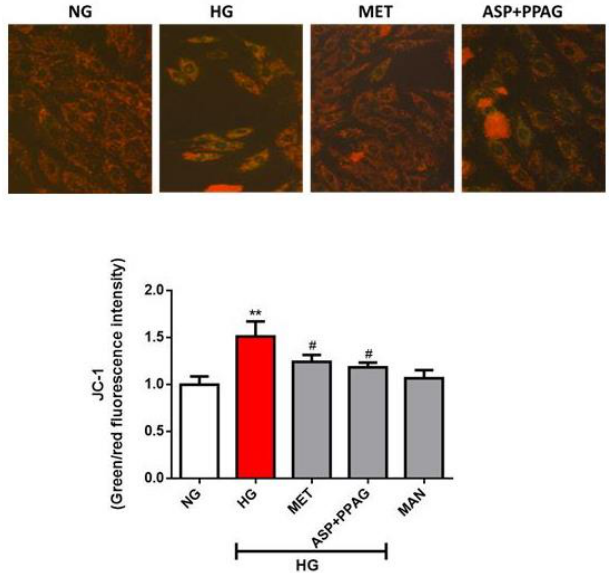
Figure 2. The combination e ff ect of aspalathin (ASP) and phenylpyruvic acid-2- O - β - d -glucoside (PPAG) in comparison to metformin (MET) in improving mitochondrial membrane potential. H9c2 cardiomyocytes were exposed to 33 mM glucose (HG) for 48 h before treatment with a combination of ASP and PPAG, as well as MET, at a dose 1 µ M for 6 h. Mannitol (MAN) at a concentration of 33 mM was used to rule out the e ff ect of osmolarity. Results are expressed as the mean ± SEM of three independent experiments relative to the normal glucose (NG) control (5.5 mM). ** p < 0.01 versus NG control; # p < 0.05 versus HG control. Supporting images of JC-1 stained (green / red fluorescence) cardiomyocytes demonstrate an apparent change in morphology and loss in cell numbers for cells exposed to high glucose concentrations when compared to treated cells and